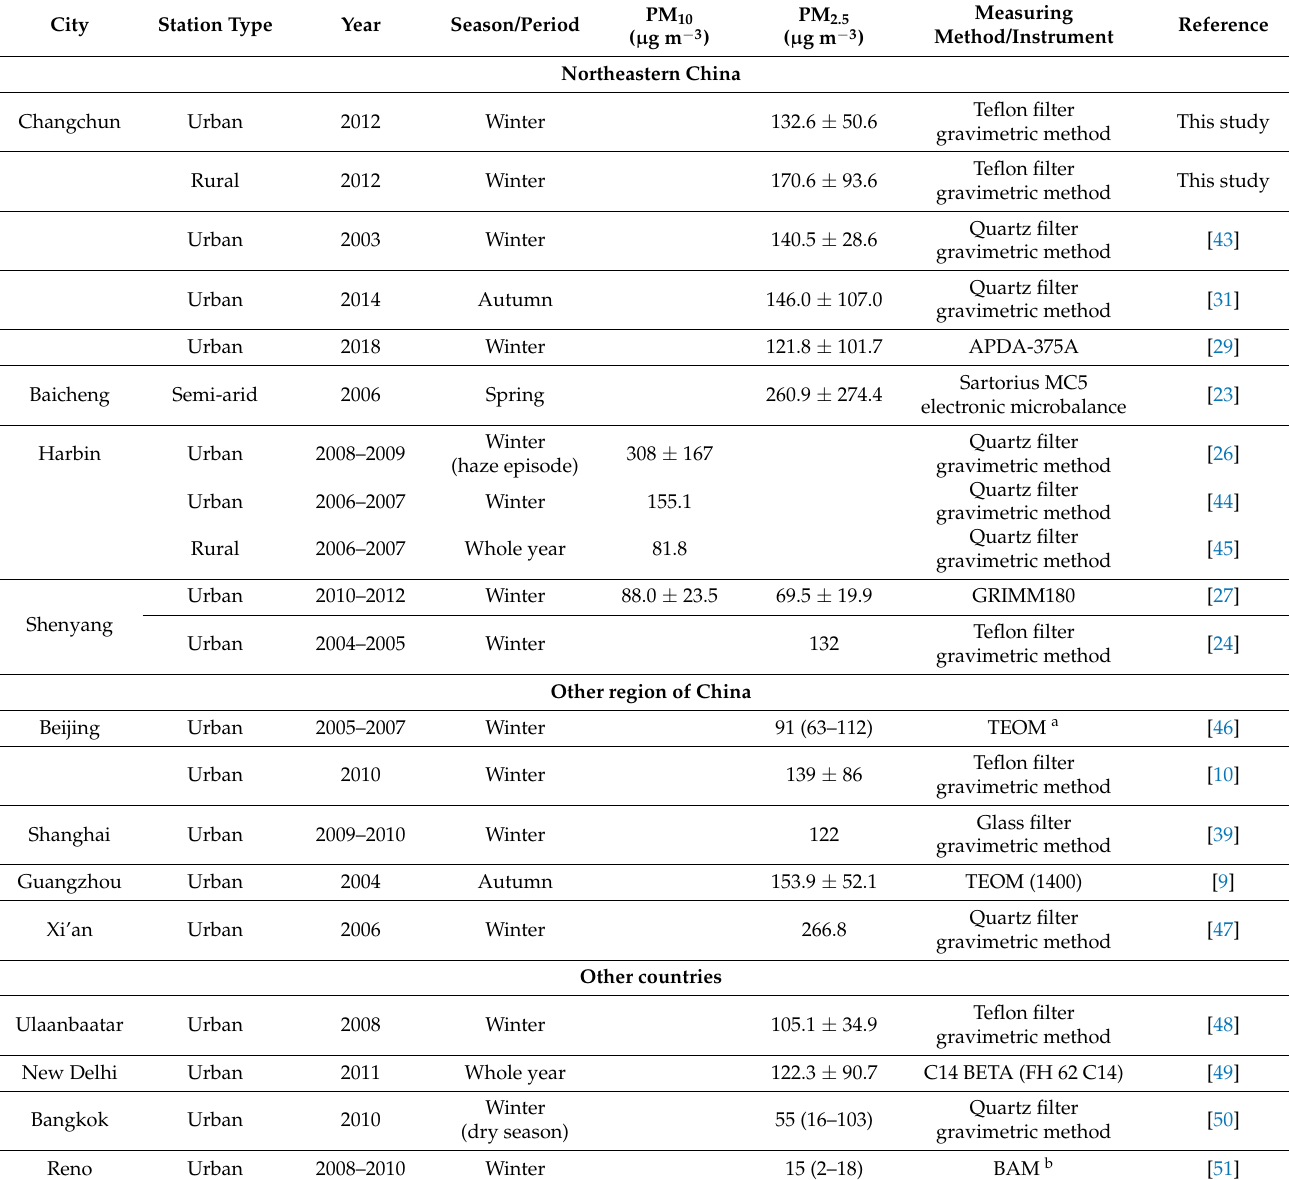
Table 3. Comparison of PM 2.5 and PM 10 mass concentrations in Northeastern China with other regions.